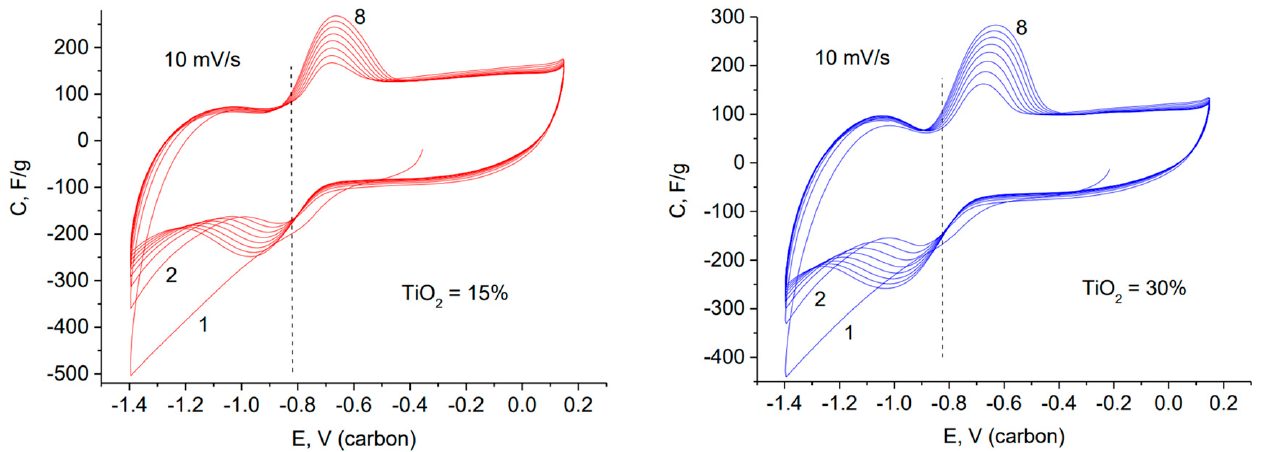
Figure 6. Cyclic cathodic polarization of the composite with 15 wt. % and 30 wt. % TiO 2 ; 8 successive cycles are shown, they lead to an increase in the reversible hydrogen pseudocapacity.